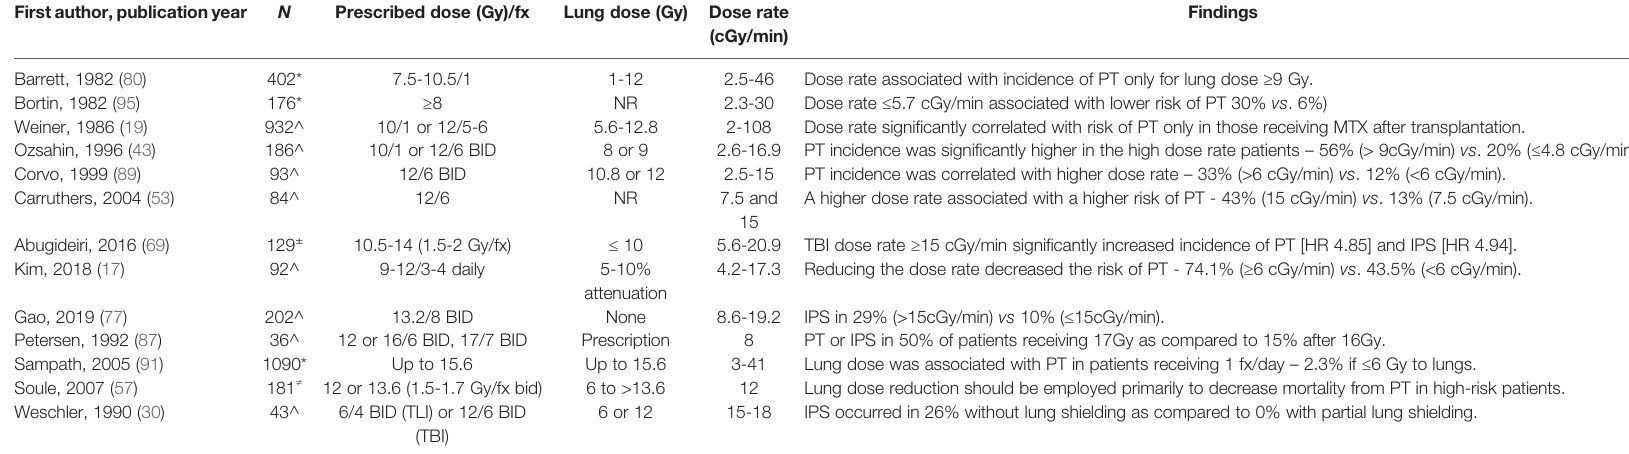
TABLE 6 | Summary of key literature reports on the effect of dose rate and lung dose.